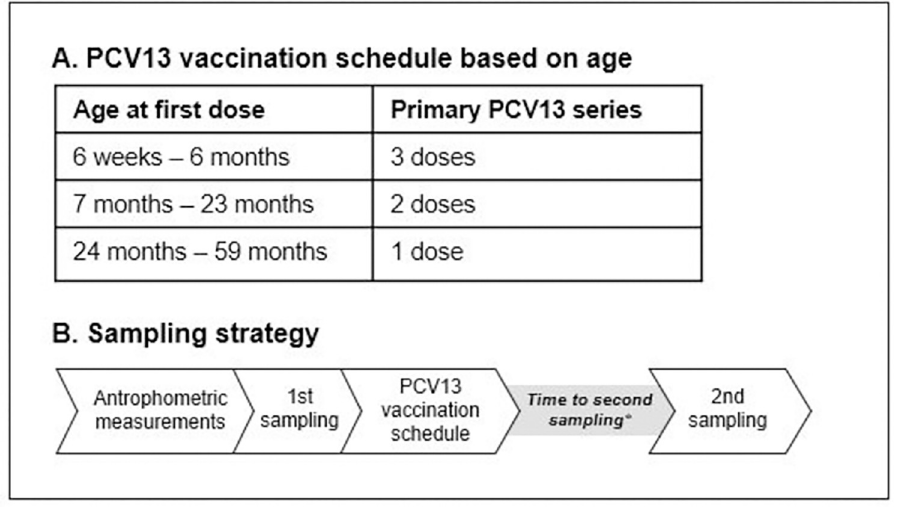
Fig 1. PCV13 vaccination schedule and sampling strategy. A. PCV13 vaccination schedule based on age. B. Overview of sampling strategy. Blood samples were taken during both the 1 st and the 2 nd sampling moment. In the pre-vaccination serum samples (1 st sampling) PCV13 IgG levels and metabolic hormones were determined. In the post-vaccination serum samples (2 nd sampling) only PCV13 IgG levels were determined. � Median 6.7 weeks (IQR 6.4–6.9